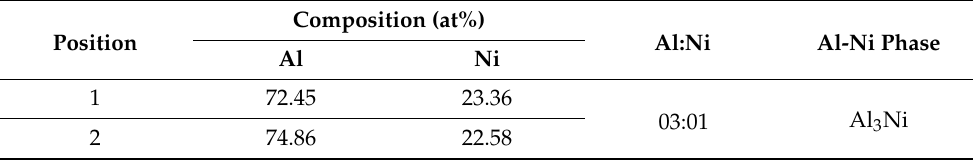
Table 3. Point analysis of Ni plated CSF/A1070 composite by EDS in Figure